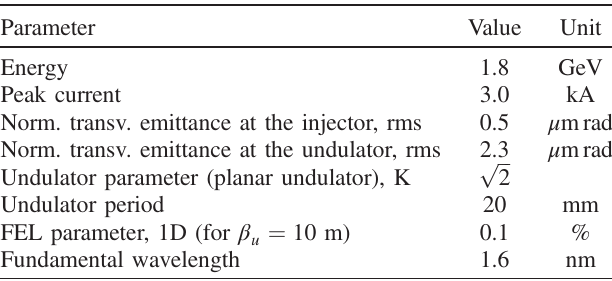
TABLE I. Parameters for the SASE FEL used to compare L [Eq. (2)] and L [4], as a function of β g; 3 D